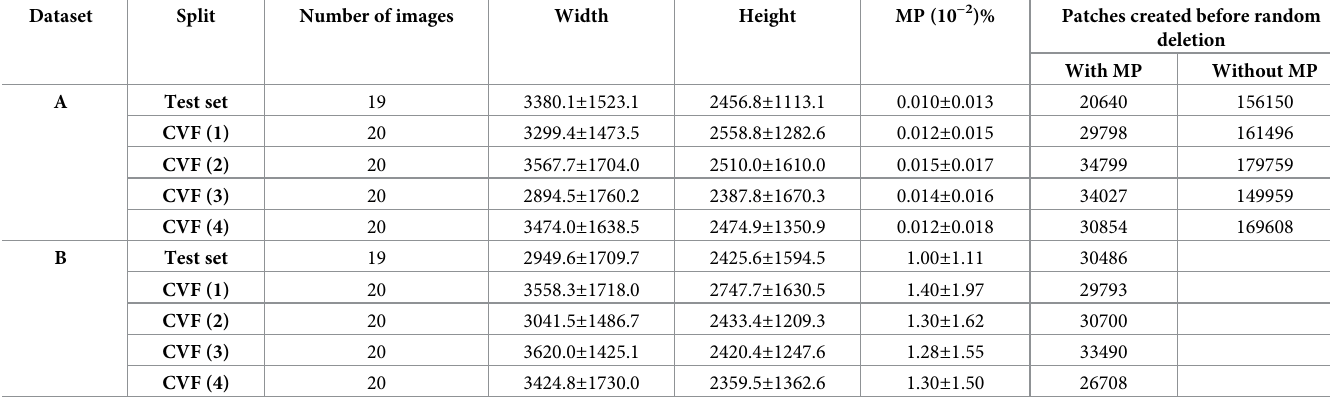
Table 3. Overview of the datasets used. The last two columns describe the patches sampled using a sliding window approach. Other values are expressed as mean ± standard deviation.